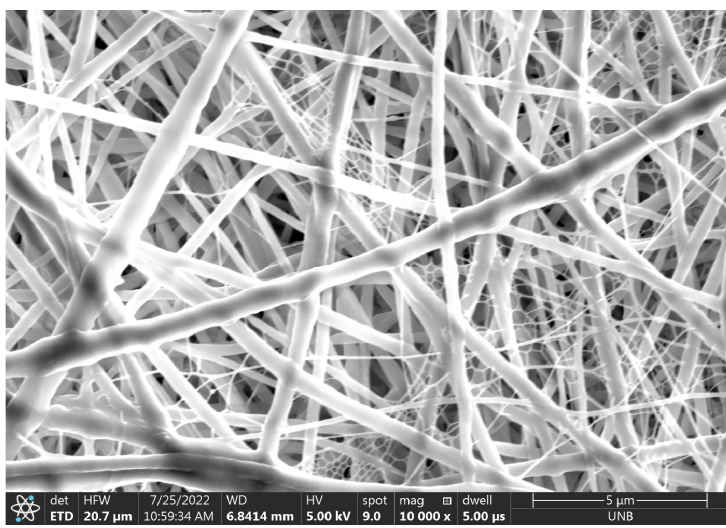
Figure 9. The 10,000x magnification of electrospun fibers from deposit 2.